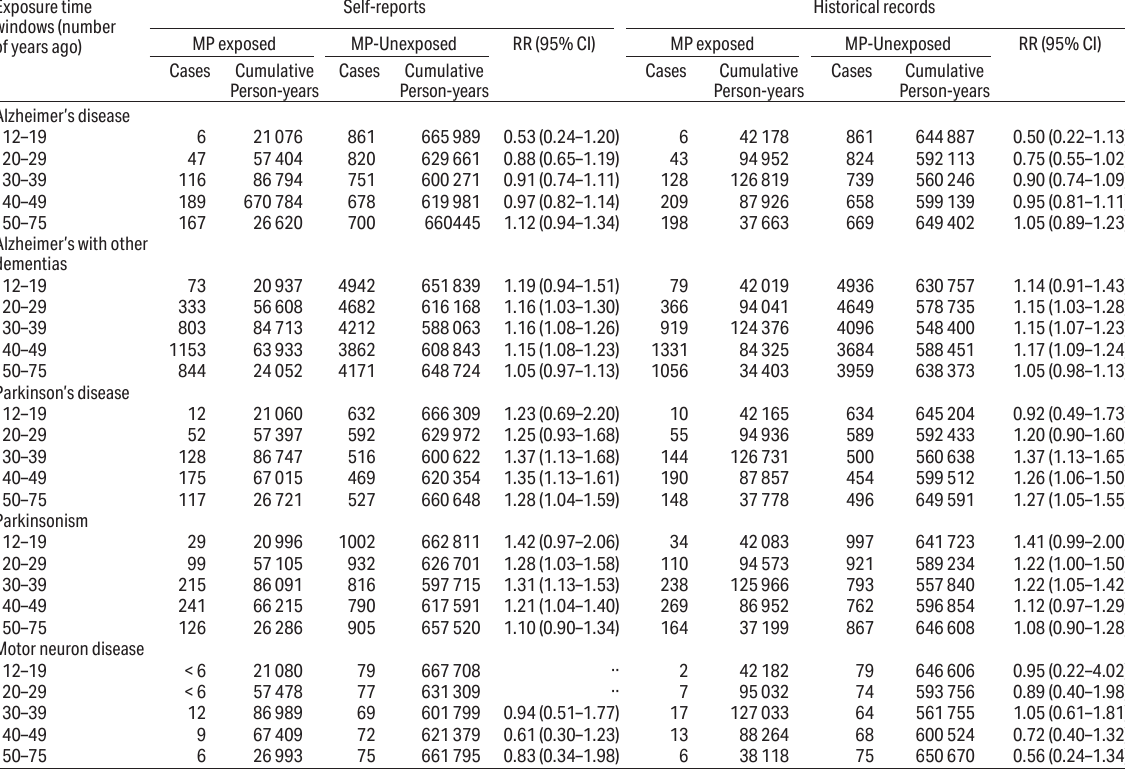
Table 5. Incidence rate ratios (RR) of neurodegenerative disease (1992–2018) for ever exposure to McIntyre Powder (MP) versus never for various exposure time windows among male miners in the study cohort. [CI=confidence interval.]